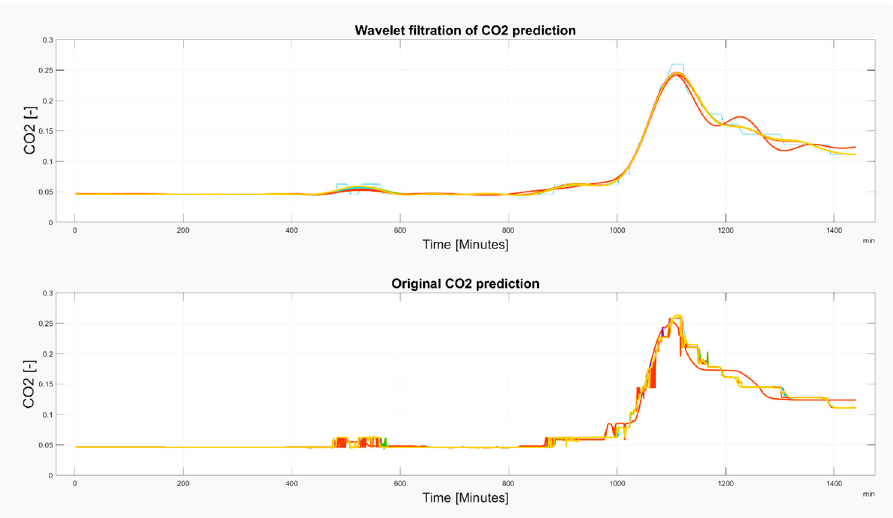
Figure 19. An example of one-day prediction from 15 th May 2018 of the CO 2 signal. Filtration is done by using the Db6 wavelet with 6-level decomposition.